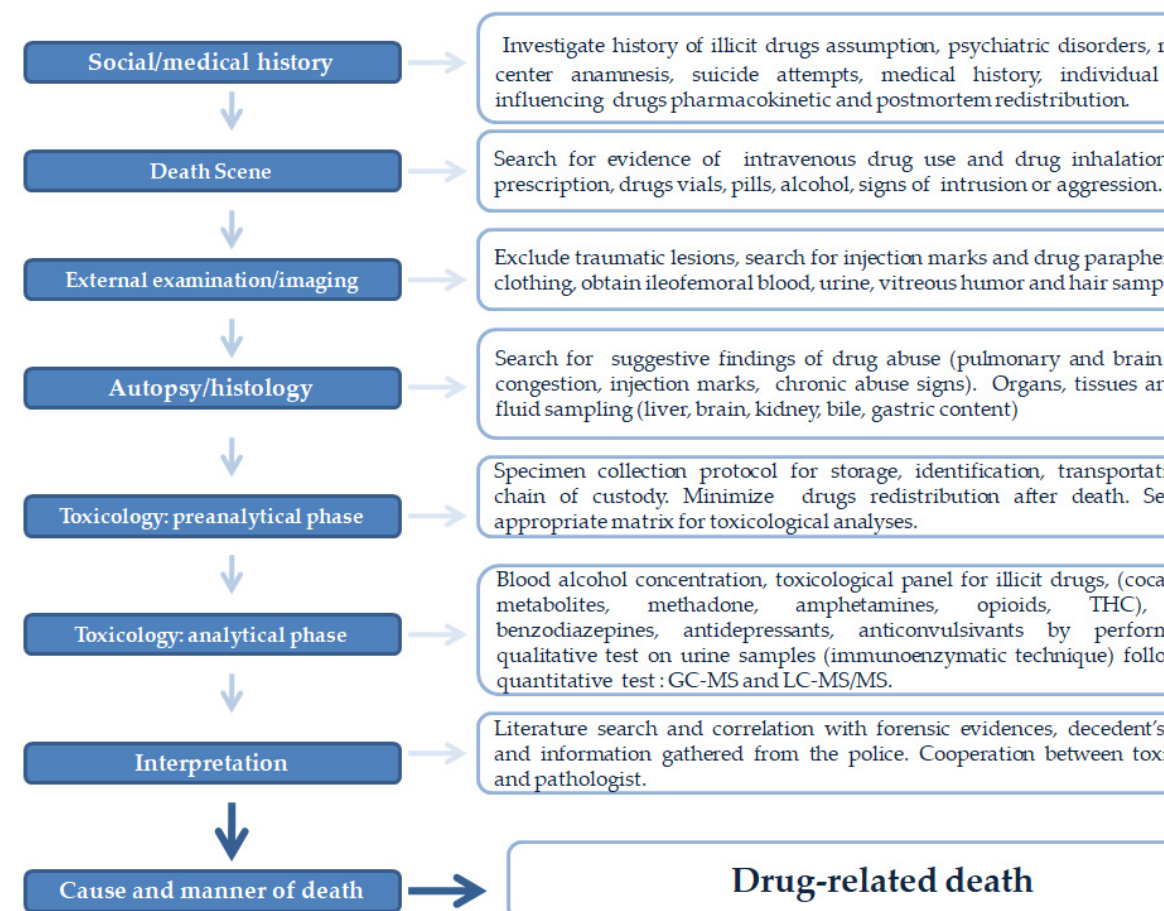
Figure 1. A diagnostic algorithm for managing suspected deaths related to the administration of drugs or abuse of substances.